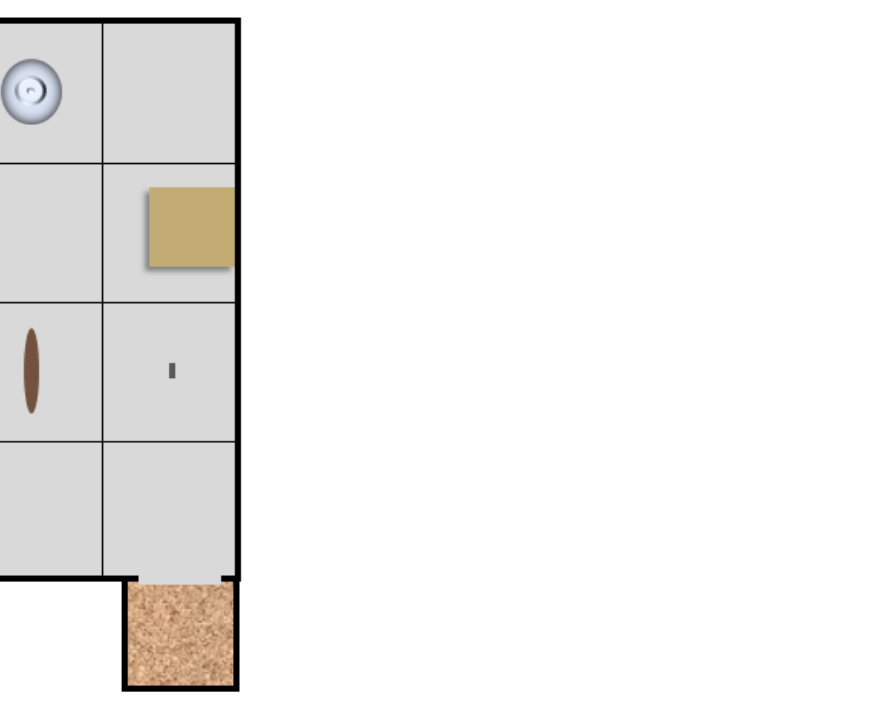
Figure 11. Schematic layout of the exploration box test. Objects from upper left quadrant clockwise: a glass jar, a cardboard box, a food pellet, a wooden handle. In control, untreated conditions, the novel objects are investigated to a rather equal extent, while the food pellet is ignored.